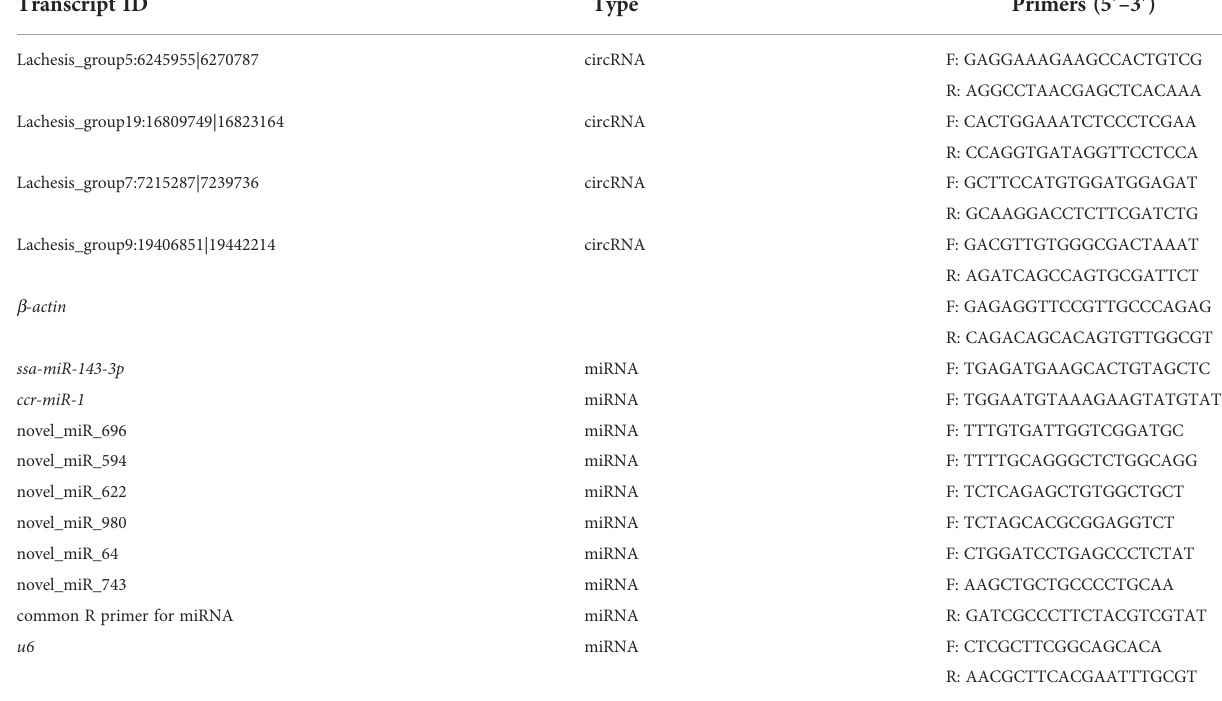
TABLE 1 Primer sequences of circRNAs and miRNAs for the qPCR